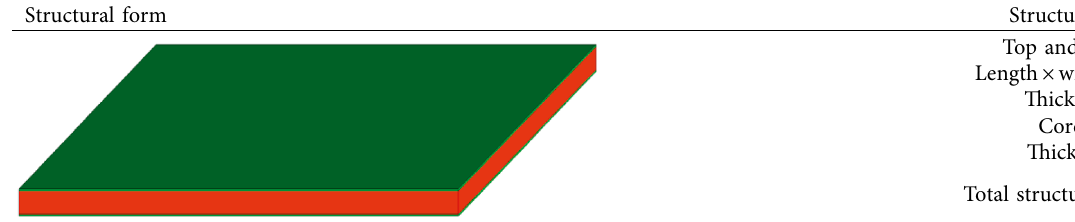
Table 4: Structural forms and parameters of SPS.